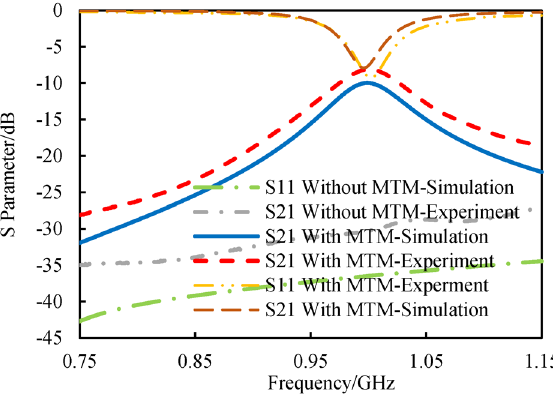
Figure 2. The simulated and experimental S parameters of the waveguide system with or without the water-based MTM.